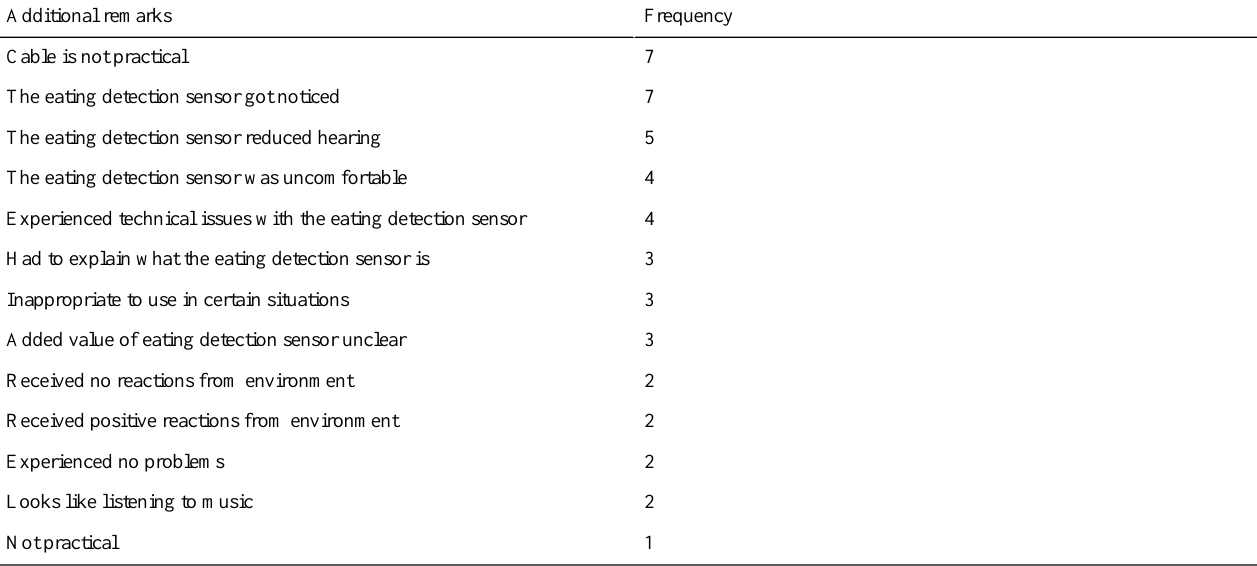
Table 2. Additional remarks regarding the eating detection sensor and their